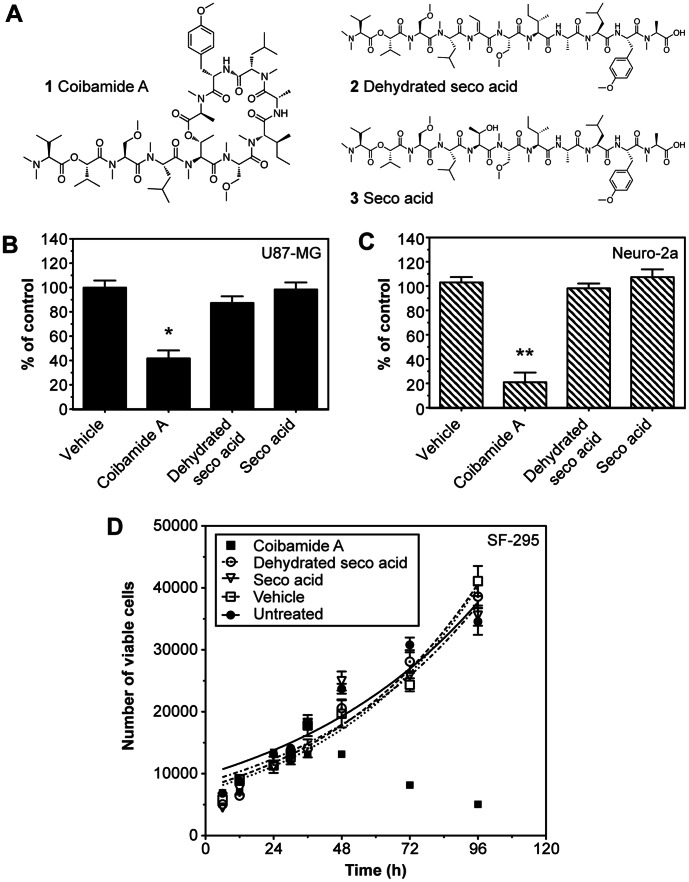
Linearized analogs of coibamide A are not cytotoxic.(A) Structures of coibamide A (1), and two linearized derivatives: dehydrated seco acid (2), and seco acid (3). (B and C) Comparison of cell viability in human U87-MG glioblastoma and mouse Neuro-2A neuroblastoma cells, respectively, following exposure to the coibamide A (20 nM) parent structure, linear forms 2 and 3 (both 30 µg/mL, ∼230–260 nM), or vehicle (DMSO) for 4 days. (D) Trypan Blue exclusion test of cell viability over 4 days in SF-295 cultures treated with or without the coibamide A (20 nM), linear forms 2 and 3 (both 30 µg/mL, ∼230–260 nM), or vehicle (DMSO). Histograms represent mean cell viability ± SE of at least three independent MTT assays performed in triplicate (*P<0.05 and ** P<0.01, coibamide A vs. control). Trypan Blue exclusion profile represents mean cell counts ± SD of a representative time course performed in triplicate that was repeated three times with similar results.